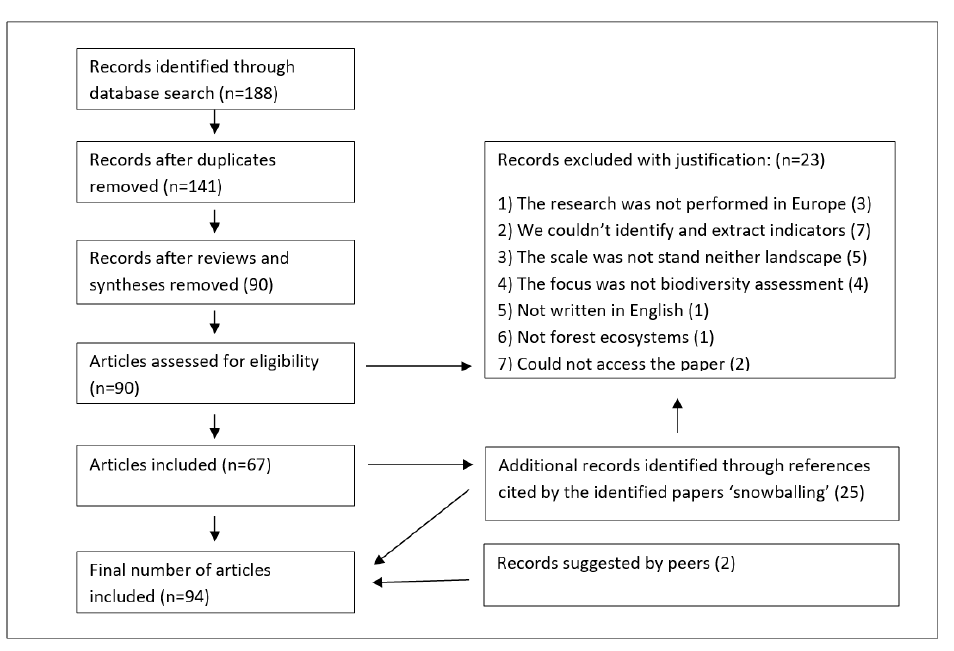
Figure 1. PRISMA (Preferred Reporting Items for Systematic reviews and Meta-Analyses) flow diagram of the literature review.